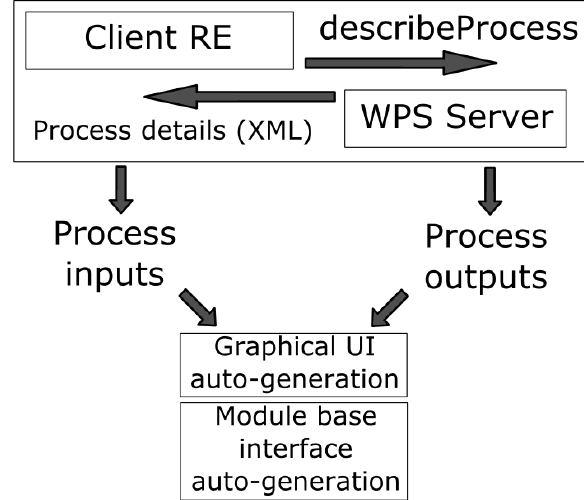
Figure 4. Second step of data exchange. Requesting